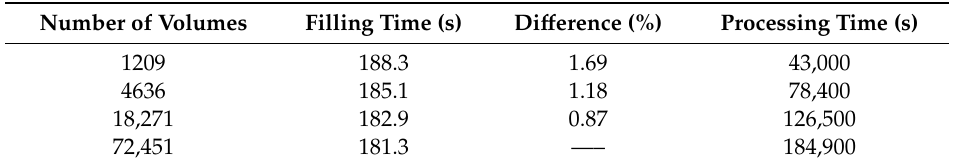
Table 2. Mesh independence test considering an I-shaped empty channel with φ = 0.05, H / L = 1.0 and L 0 / H 0 =